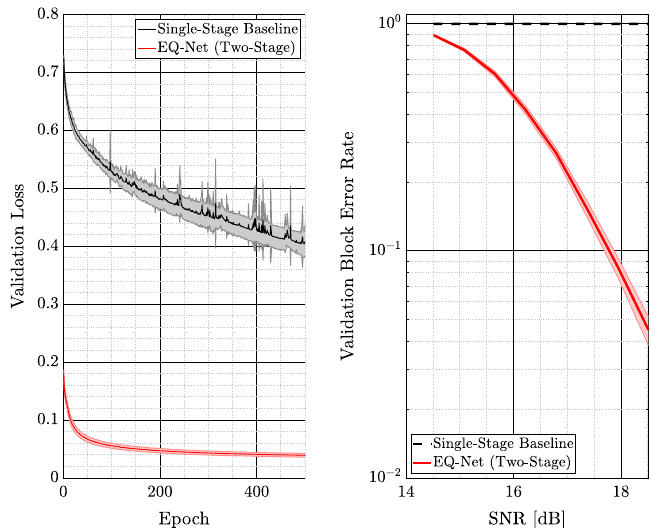
Fig. 6 Comparing the two-stage training of EQ-Net and a naïve supervised baseline that jointly trains the estimation encoder and the decoder from scratch, in a single stage. In both cases, the networks have the same architecture and initial weights, and the same number of gradient updates is performed. The plot includes shaded standard deviation areas over ten runs. (Left) Validation error (soft bit distortion). (Right) Validation coded block error rate with models taken after 500